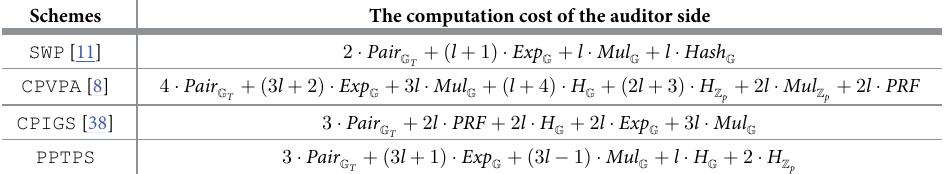
Table 4. The computation cost of the auditor